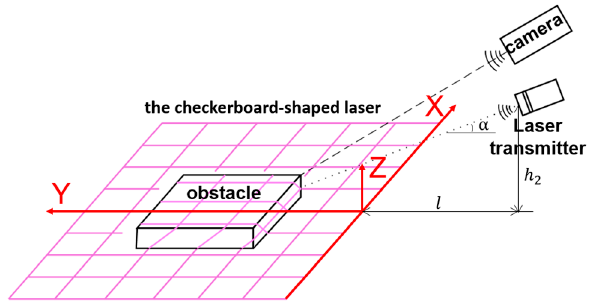
Figure 4. Rendering of the laser grid on the ground.